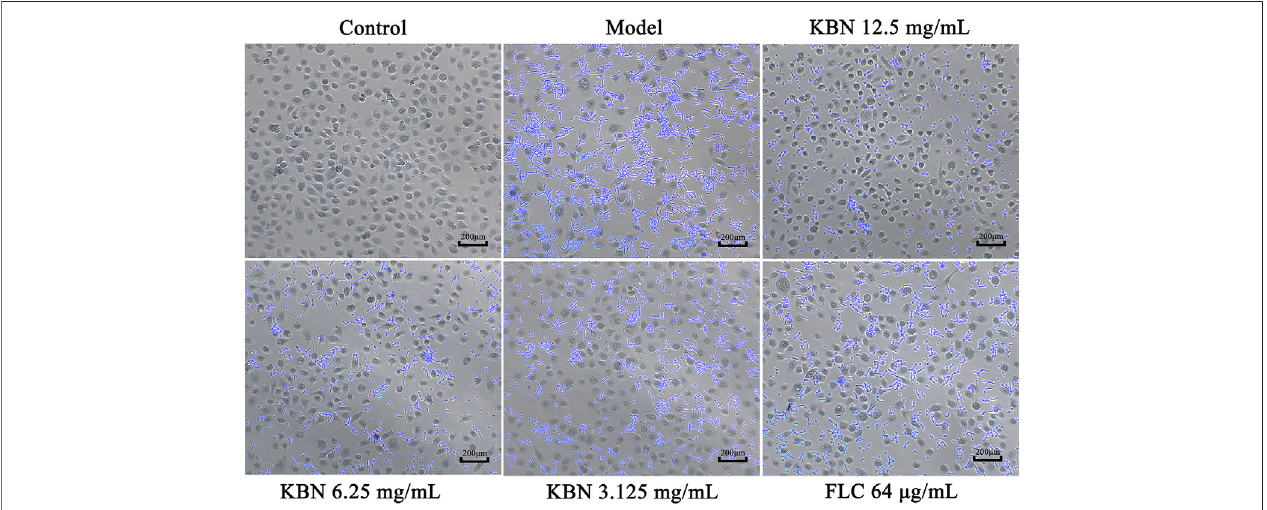
FIGURE 6 | KBN inhibited the adhesion of FLC-resistant C. albicans 901 to VK2/E6E7 cells. The treatment concentration for KBN were 12.5, 6.25, and 3.125